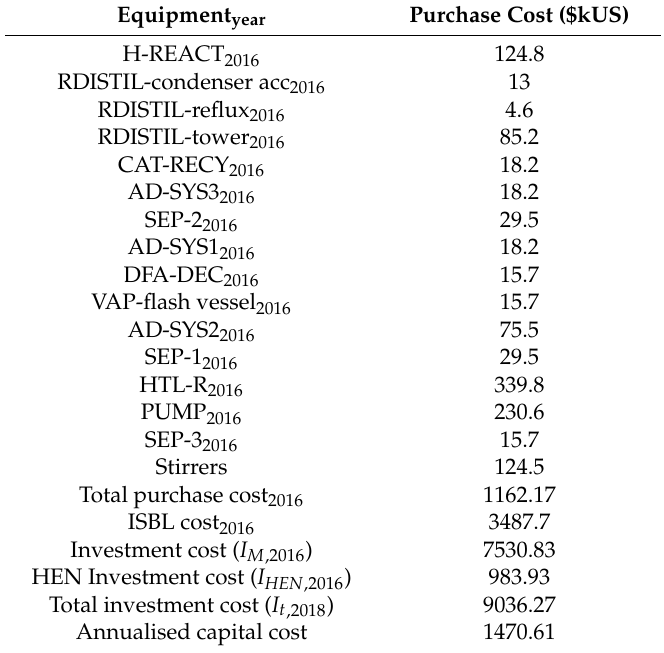
Table 4. Purchase and investment costs for the biorefinery process (Equations (9)–(19)).